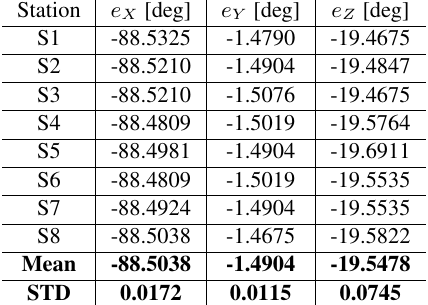
Table 3. Eccentricities adjusted values obtained for Camera